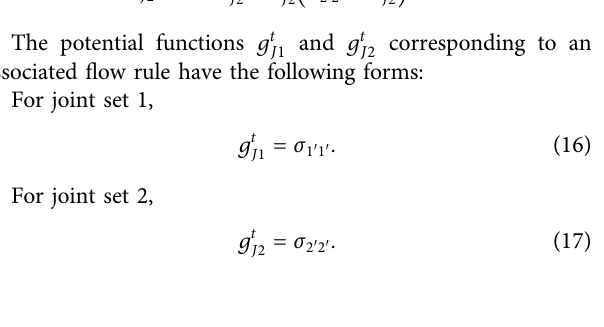
Frontiers in Earth Science |